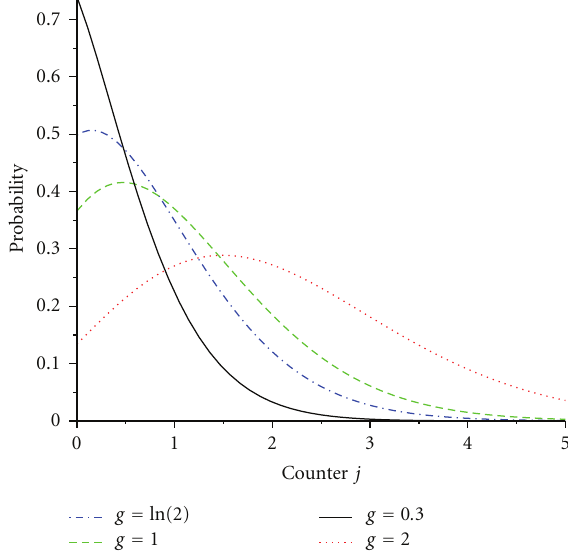
Figure 3: The counter probability distribution for di ff erent config- urations in counting Bloom